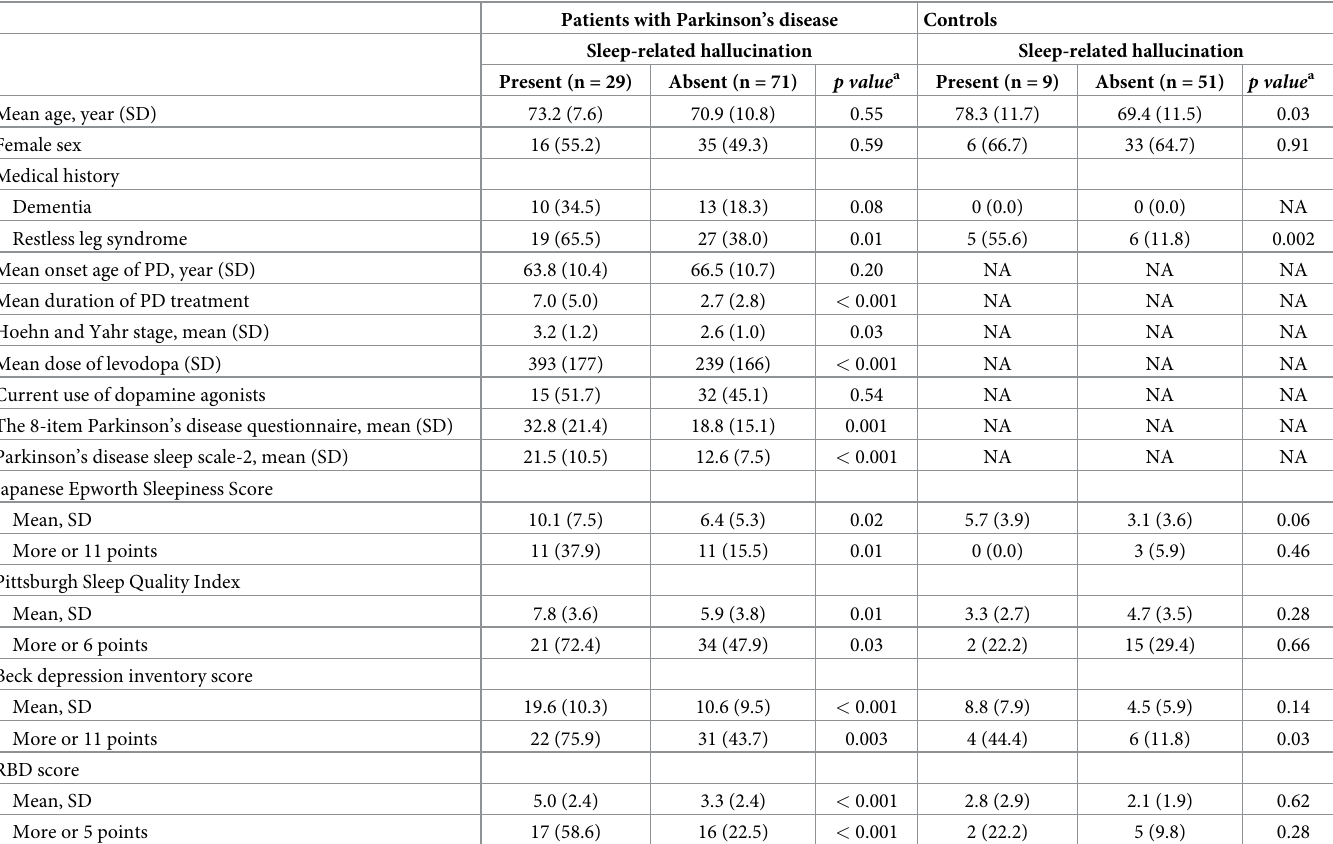
Table 2. Characteristics of patients with Parkinson’s disease and controls with and without sleep-related hallucinations.